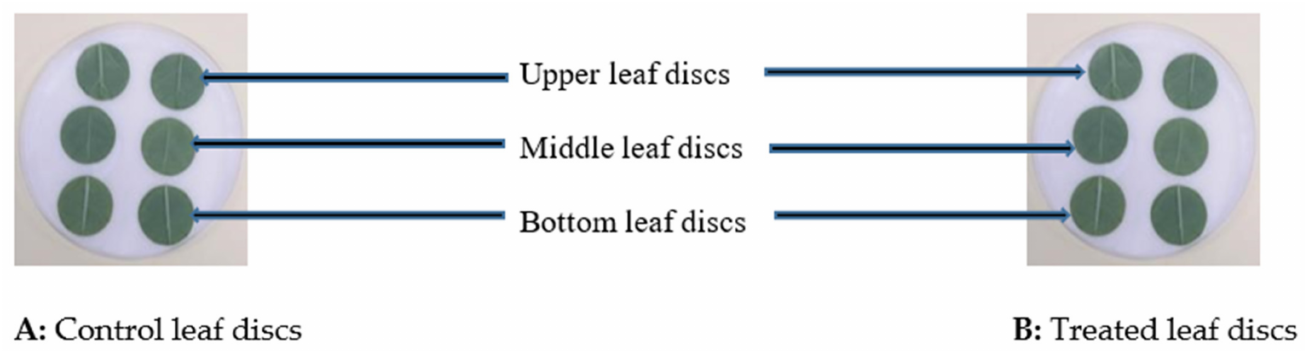
Figure 2. Assessment on control ( A ) and fungus-treated ( B ) leaves sampled from a single